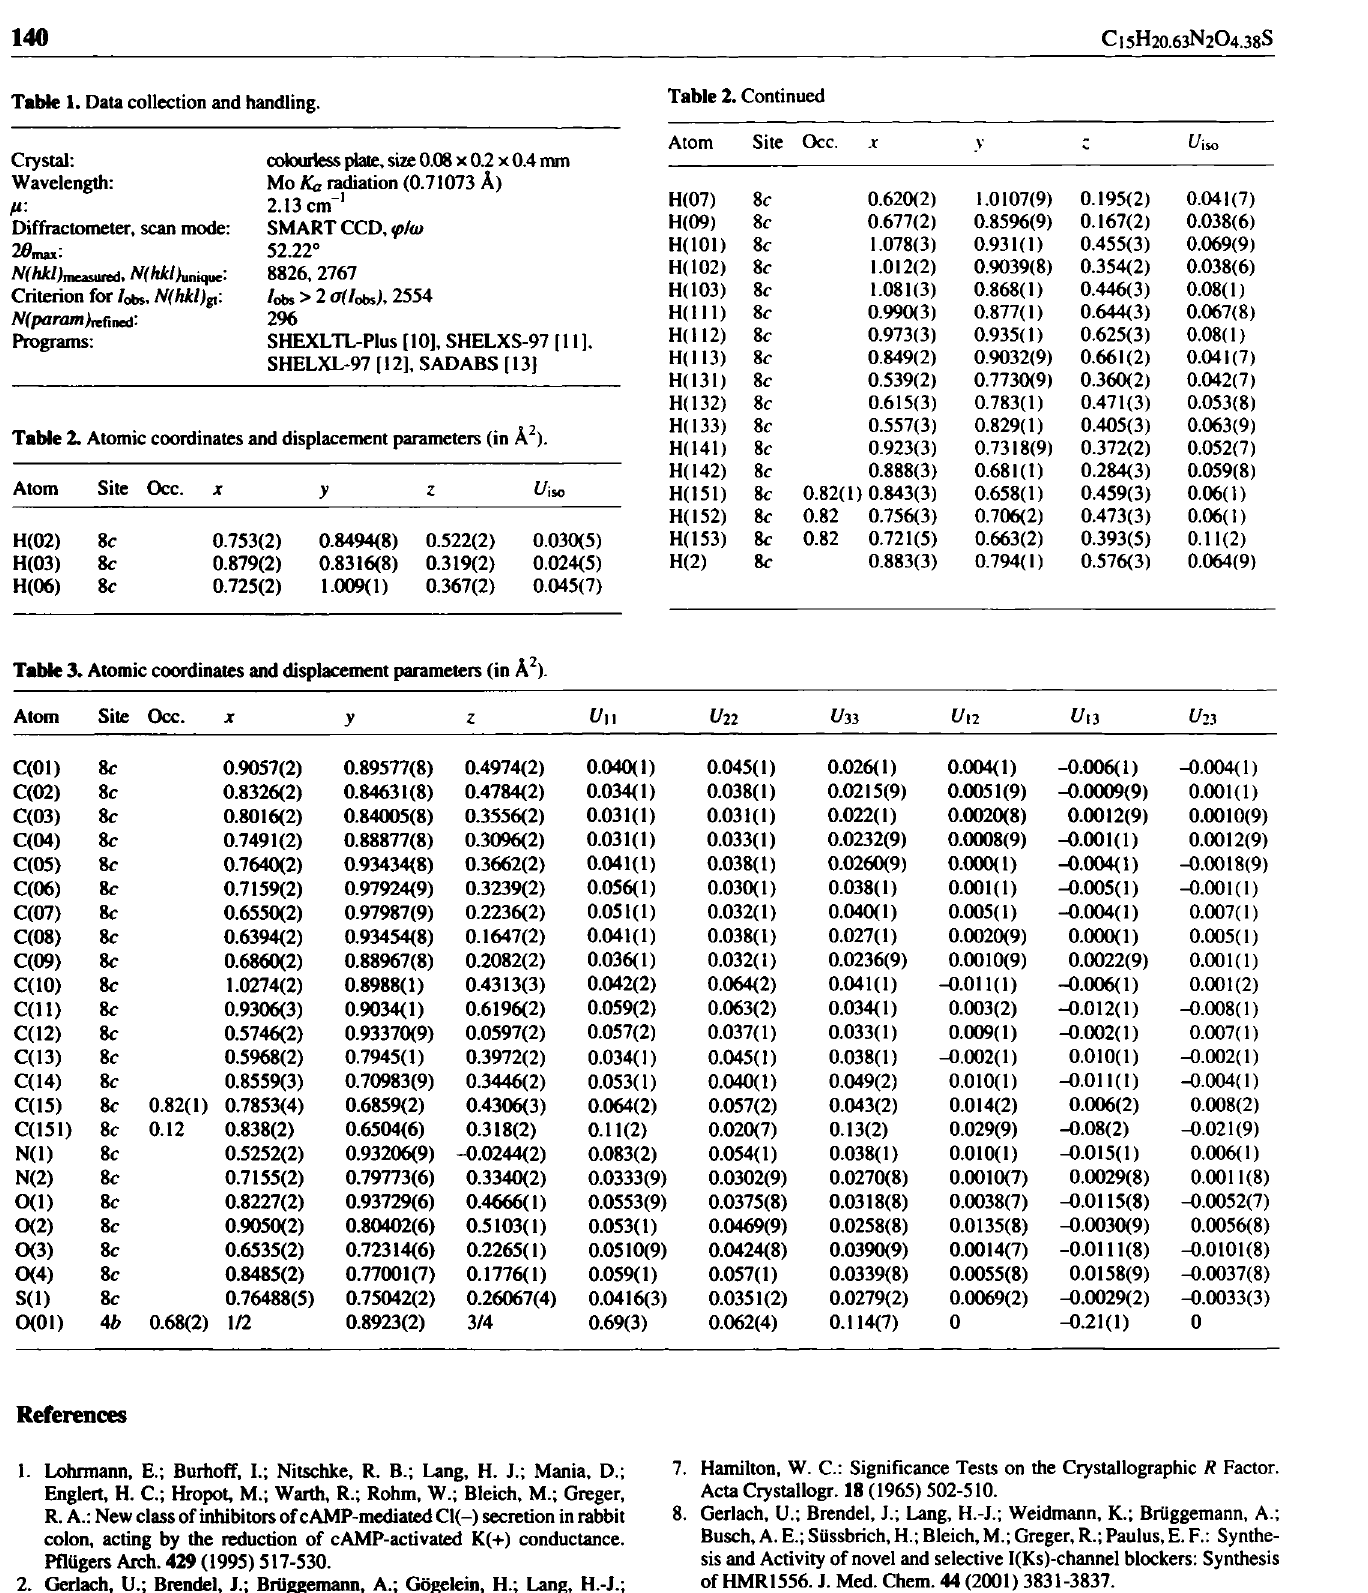
Table 2. Atomic coordinates and displacement parameters (in À 2 ).